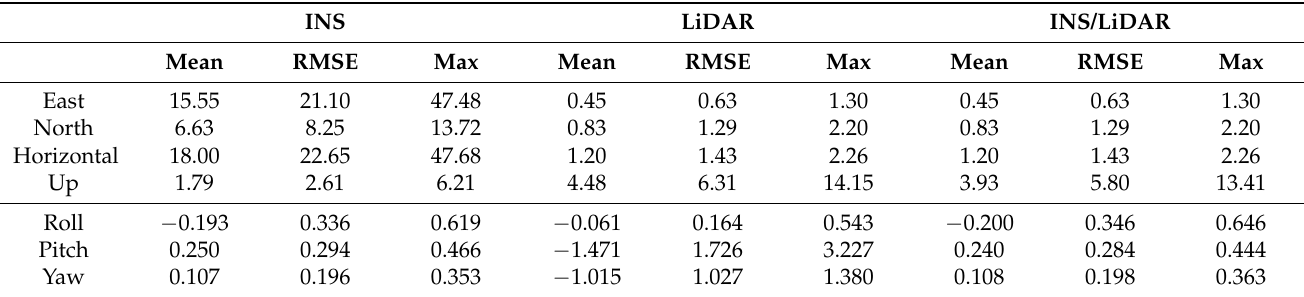
Table A5. D-23—position (m) and attitude (deg) error